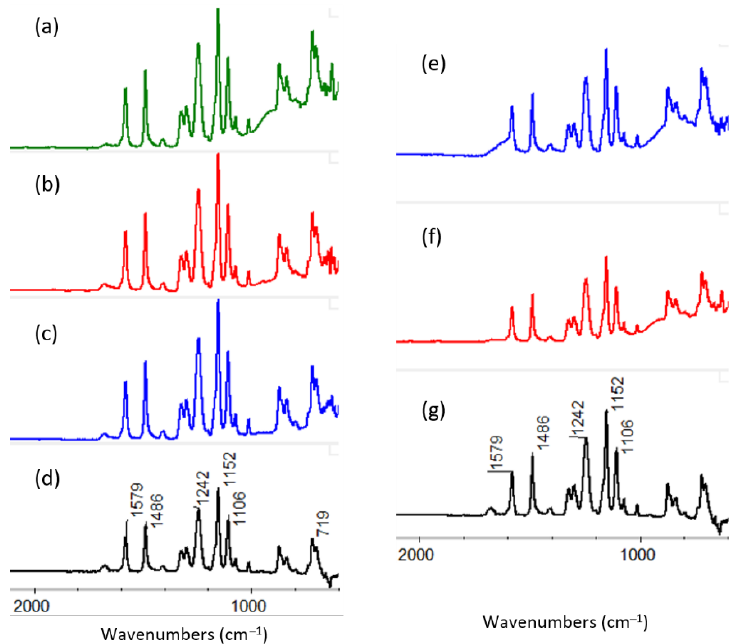
Figure 8. ATR-FTIR spectra of PES fibres with Al 2 O 3 coatings with varying nominal thickness. On the left: ( a ) 30 nm (green), ( b ) 5 nm (red), ( c ) 2 nm (blue), and ( d ) uncoated (black). On the right: ( e ) 30 nm Al 2 O 3 (TMA + O 3 ) coating (blue), ( f ) 30 nm Al 2 O 3 (TMA + H 2 O) coating (red) and ( g ) uncoated (black).